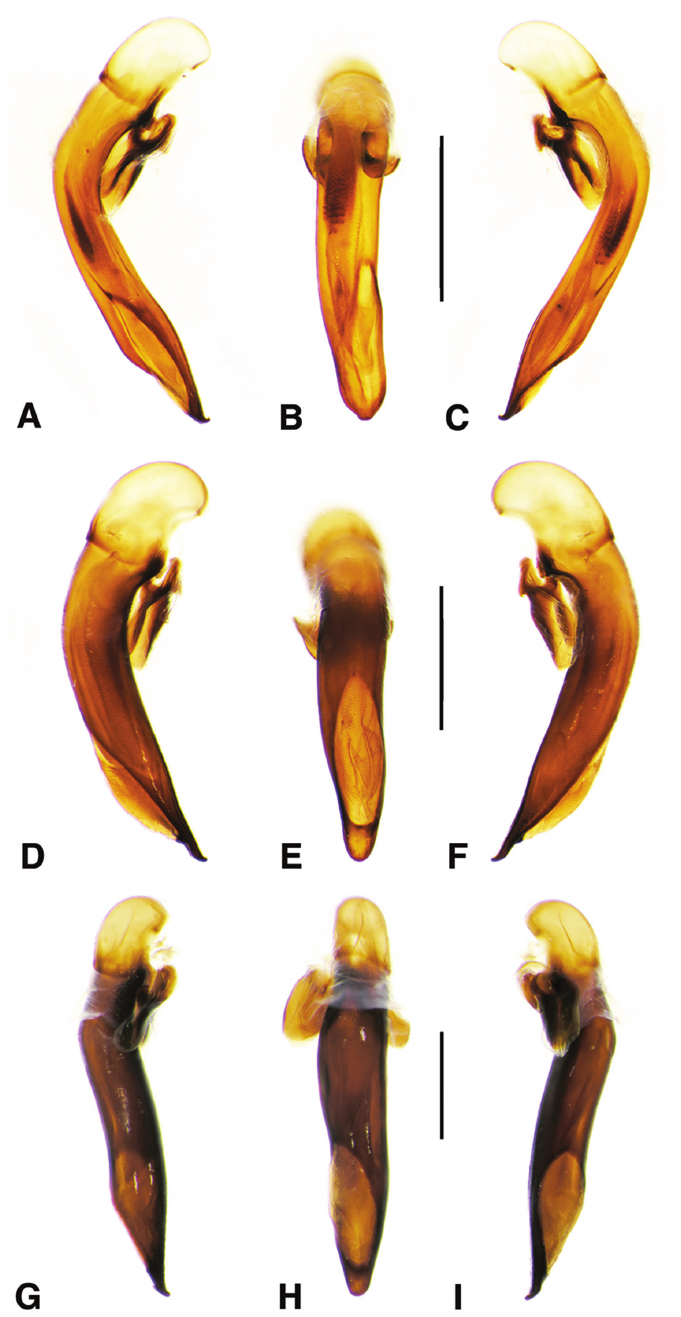
Figure 43. Digital images of male genitalia of Selenophorus opalinus species group, in part. A, D, G right lateral aspect B, E, H dorsal aspect C, F, I left lateral aspect. A–C S. integer (Fabricius) D–F S. opalinus LeConte G–I S. propinquus Putzeys. Scale bars 1